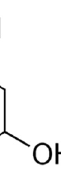
Figure 5: Phloroglucinol ( Source Figueirinha and Cotas in Cotas et al., 2020 )